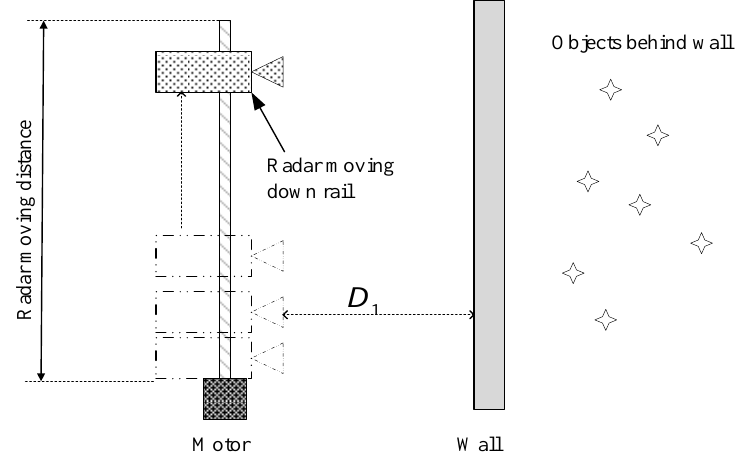
Figure 3. TWRI SAR geometry in [31].